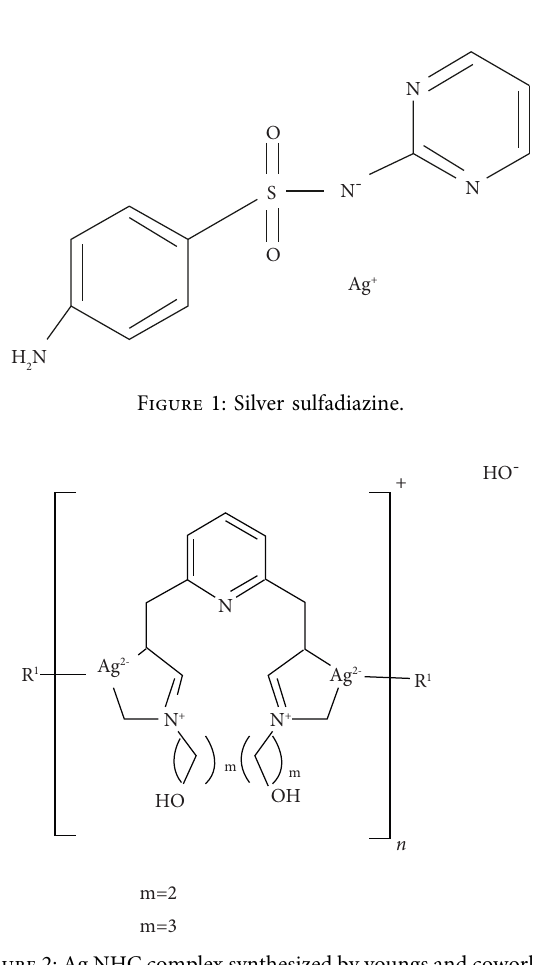
Figure 2: Ag NHC complex synthesized by youngs and coworkers.